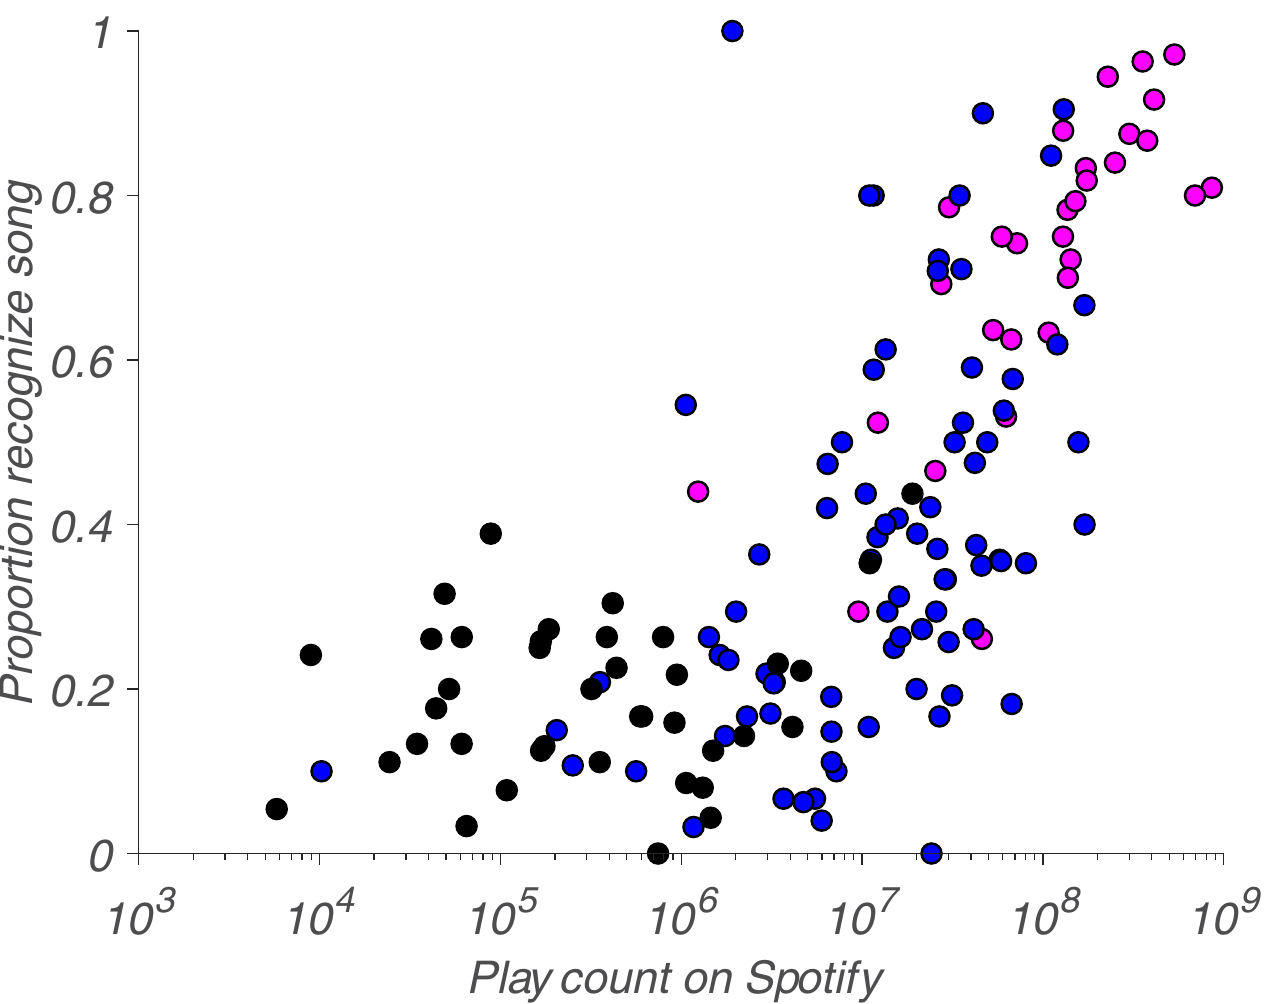
Fig 4. Song recognition versus play count. Magenta dots represent songs from Phase 1 (2001 to 2015), blue dots represent songs from Phase 2 (1960 to 2000) and black dots represent songs from Phase 3 (1940 to 1959).